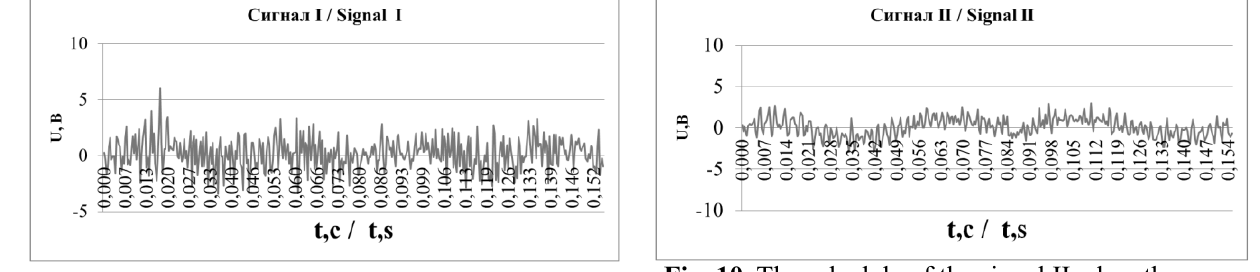
Fig. 9. The schedule of the signal I when metal balls are placed in the sensor case.